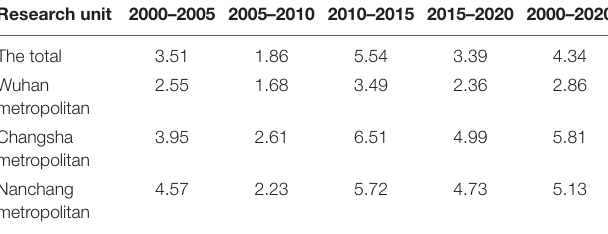
TABLE 2 | Intensity index of construction land expansion in three metropolitan regions from 2000 to 2020